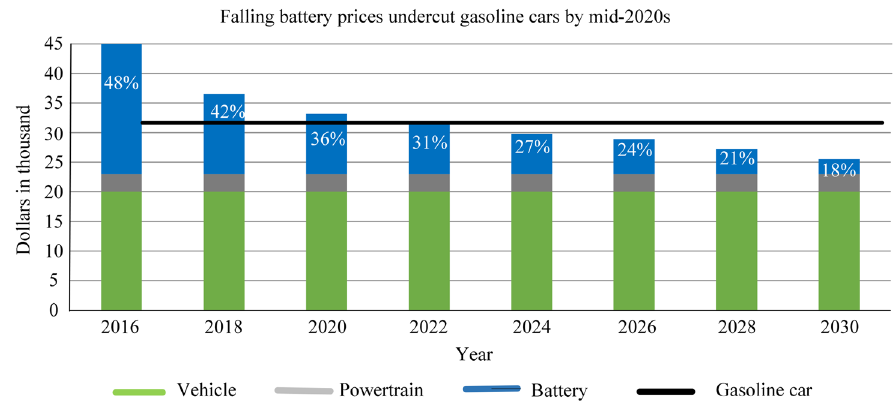
Fig. 8 Price fall status of hybrid